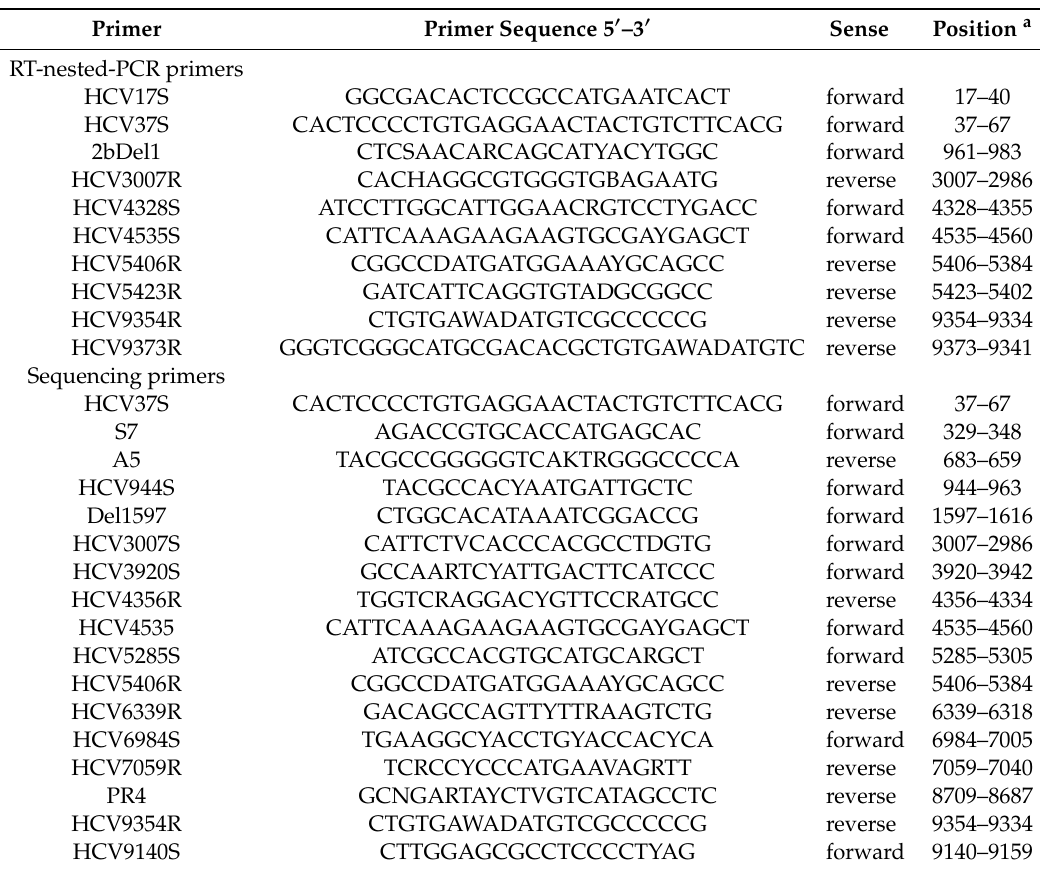
Table 1. Primers used for amplification and sequencing of the HCV genome.